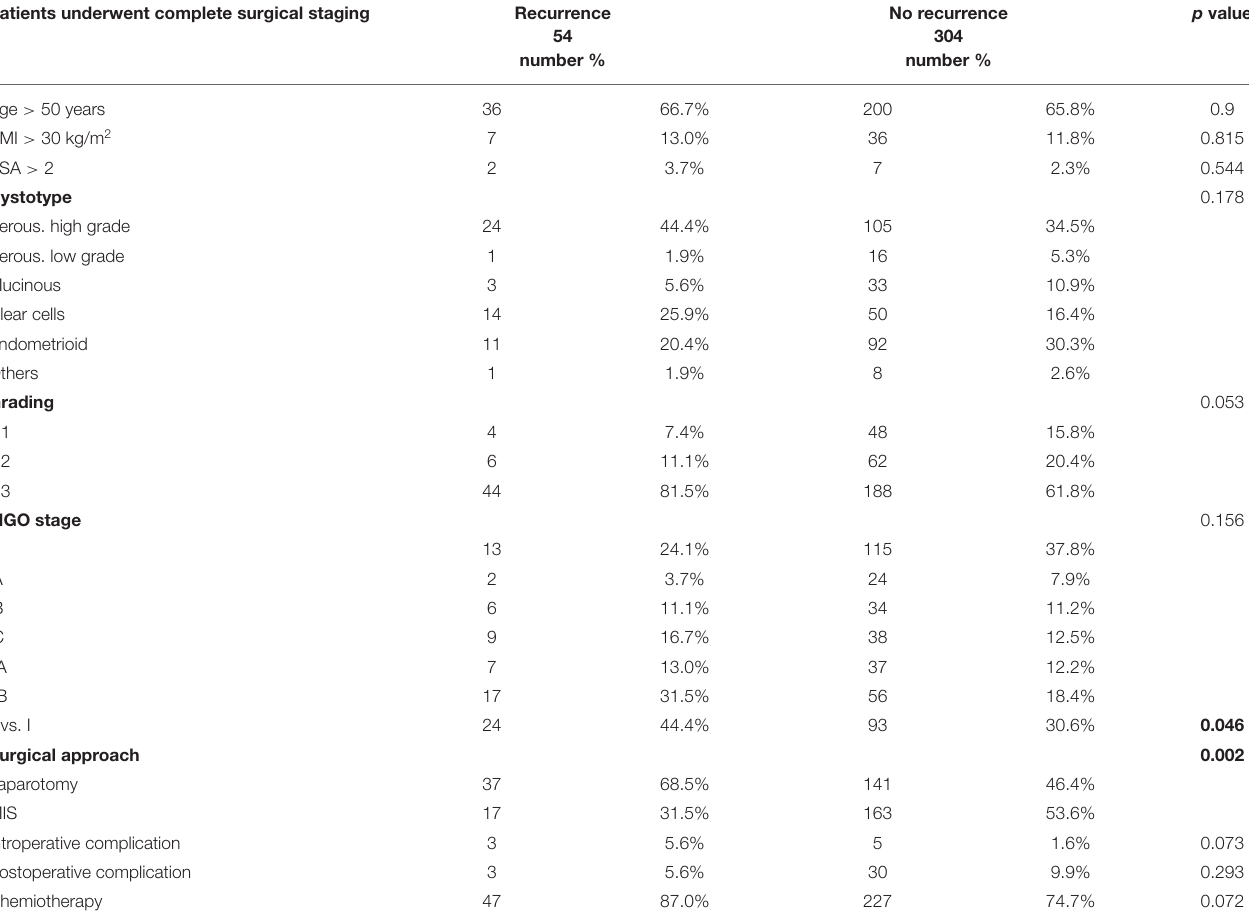
TABLE 6 | Univariate